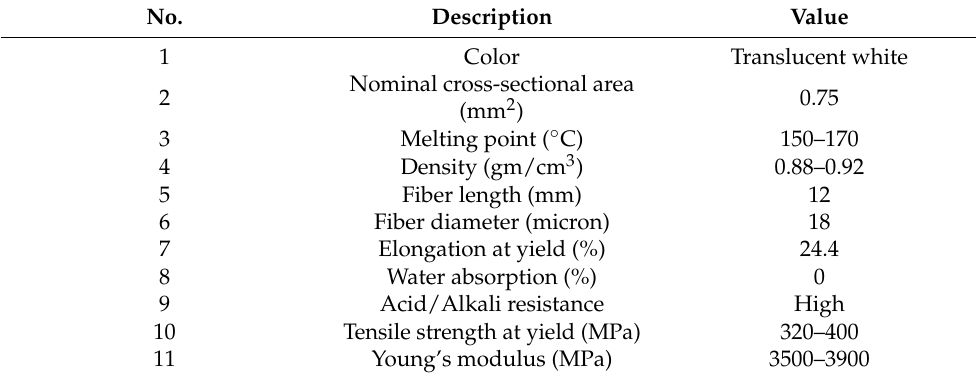
Table 4. Properties of polypropylene